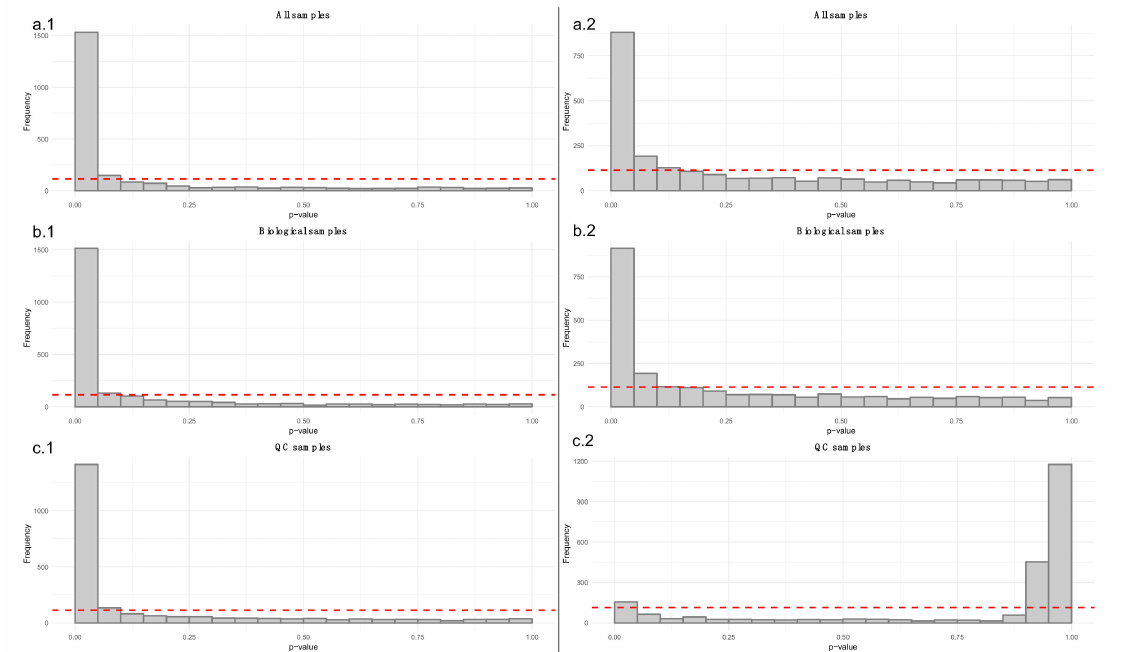
Figure 5. The six histograms illustrate p -values from linear regression models between each feature and injection order. The dashed red lines represent the uniform distribution. The a.1 and a.2 histograms show the p -values from before ( a.1 ) and after drift correction ( a.2 ) in all the samples. The b.1 and b.2 histograms focus only in the biological samples before ( b.1 ) and after ( b.2 ) drift correction. Finally, the c.1 and c.2 histograms show only the p -values from the quality control (QC) samples before and after drift correction. In this case, we have a strong drift in the LC–MS data because the p -values of the QCs ( c.1 ) tend to gather close to zero. After the drift correction, ( c.2 ), p -values for the QCs are increased.